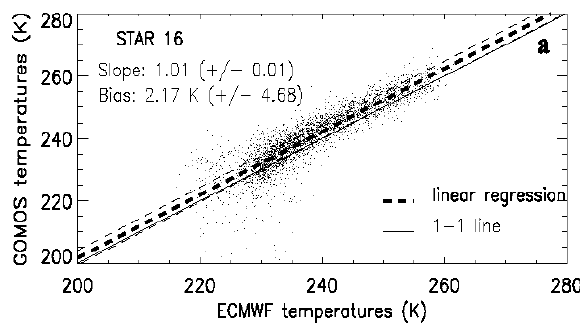
Fig. 36. Temperature retrieved from NO 3 and O 3 GOMOS data (star number 16, Antarès Alpha Scorpio) as a function of the corresponding ECMWF temperature. The slope is 1.01 ± 0.01. GOMOS-retrieved temperatures are warmer by about 2 K than ECMWF temperatures. When more stars are included in the study, the bias is found to be 2.67 K (from Marchand et al., 2007). Fig. 34. NO 3 mixing ratio at 40 km versus European Centre for Medium-Range Weather Forecasts' (ECMWF) temperature at 3 hPa ( ∼ 40 km), a result of the temperature-dependent reaction rate producing NO 3 (from Hauchecorne et al., 2005).